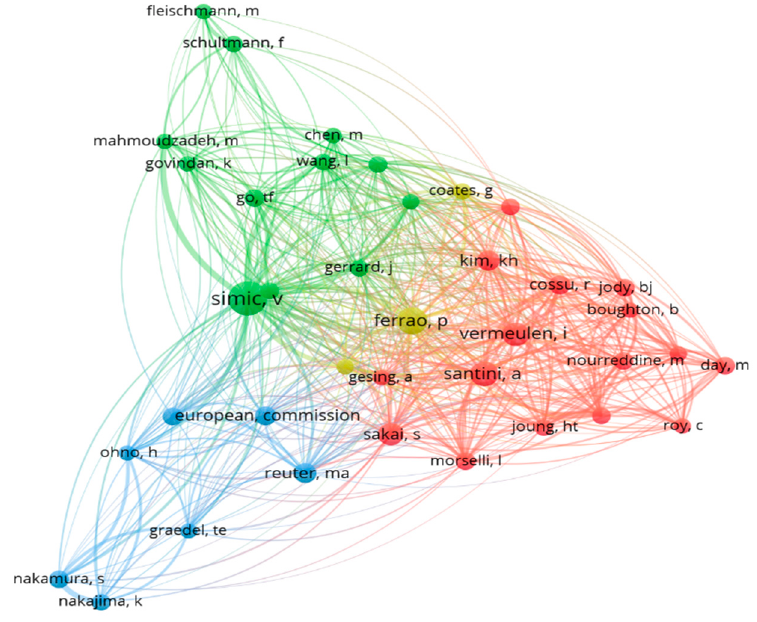
Figure 8. Author co-citation network visualization map.